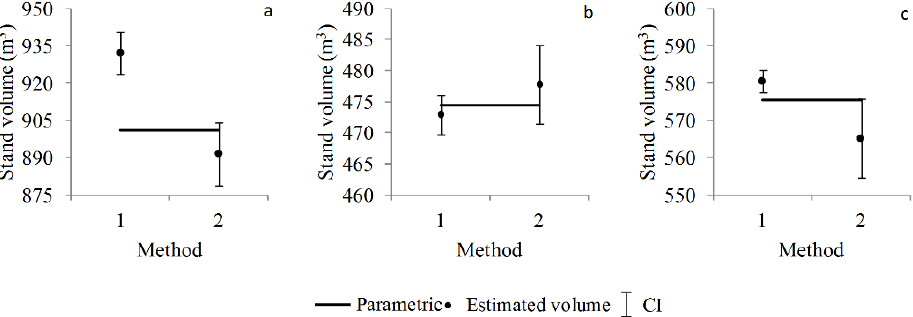
Figure 4. Confidence intervals for the area approach (method 1) by Bootstrap resampling and the individual approach (method 2) in stand 1 ( a ), stand 2 ( b ), and stand 3 ( c ).